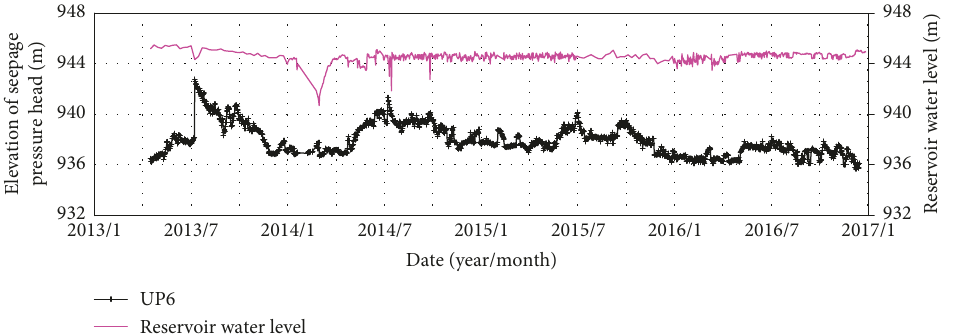
Figure 10: Time series for seepage pressure head at UP6 and reservoir water level.